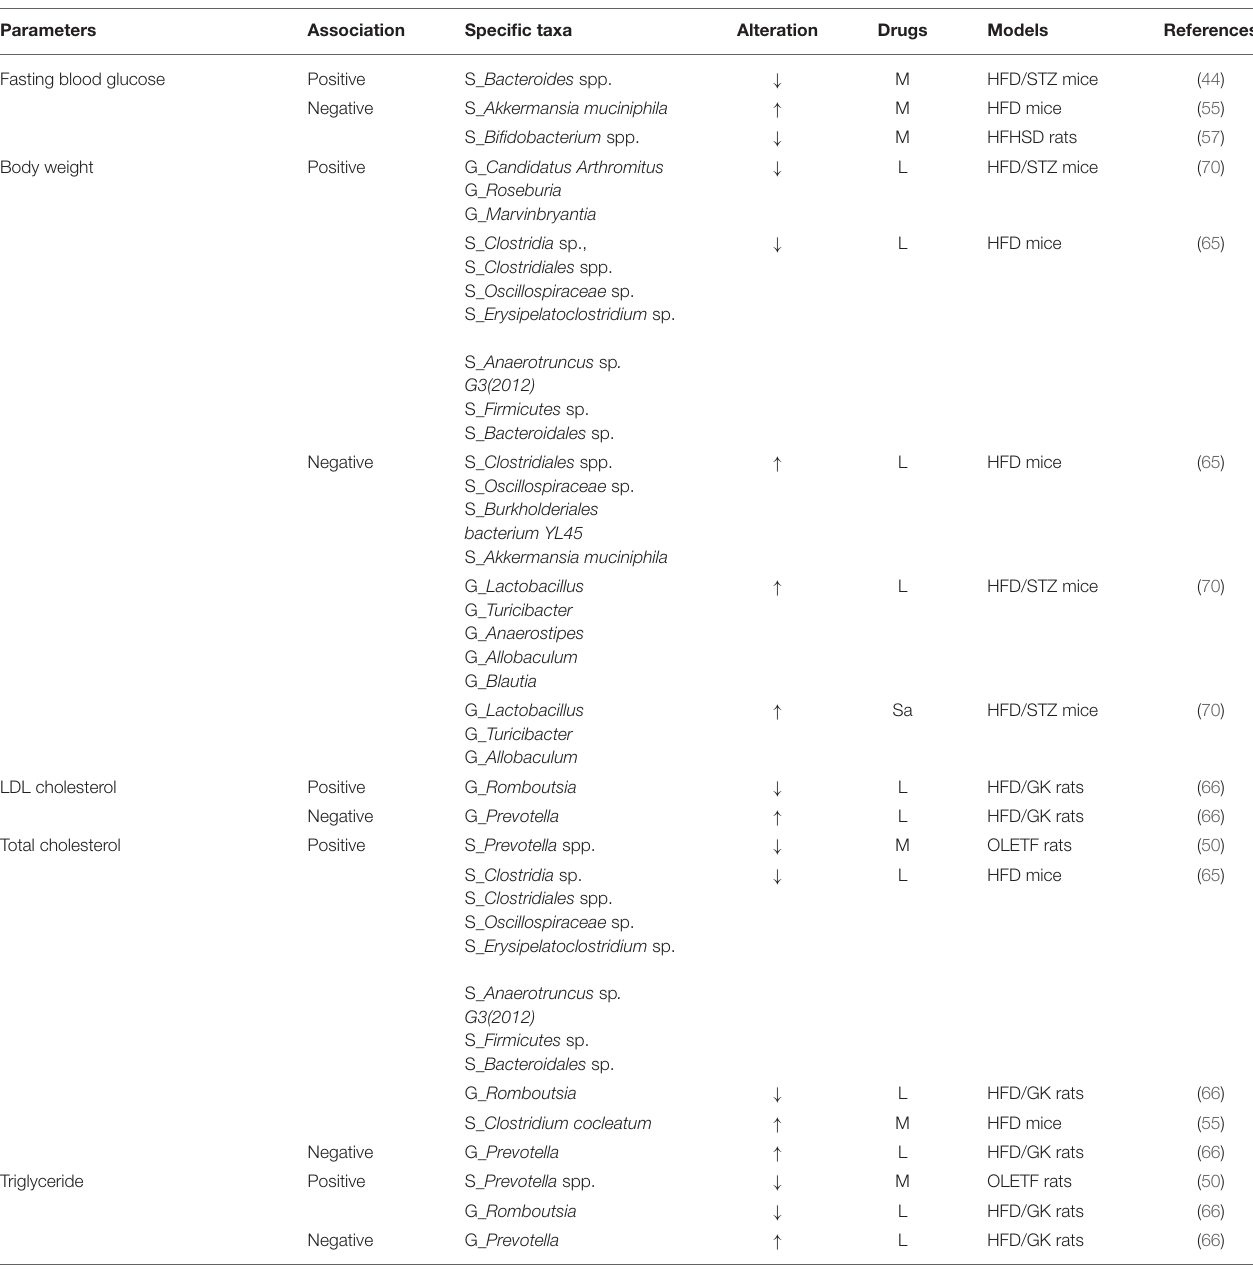
TABLE 11 | Association between specific taxa and mouse metabolic